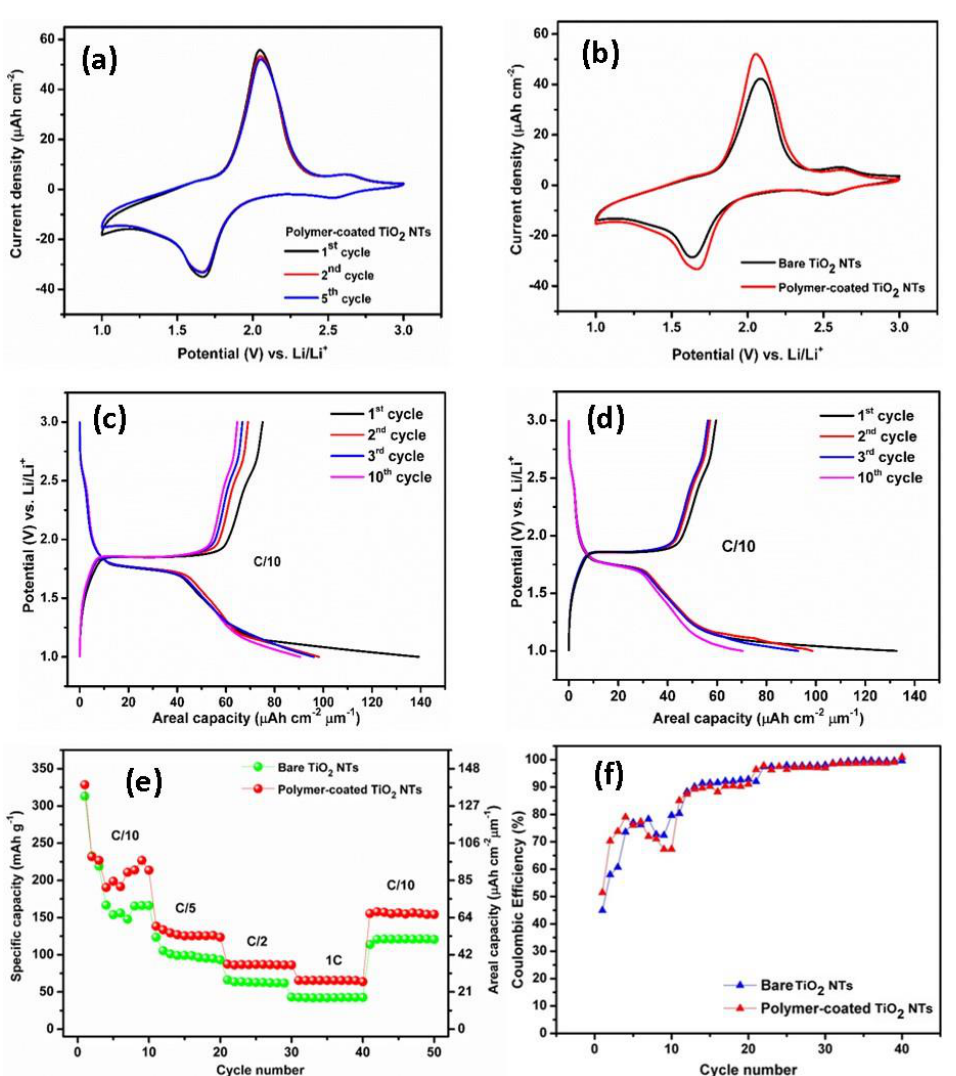
Figure 5. Cyclic voltammogram of the polymer-coated TiO 2 NTs ( a ). Comparison of cyclic voltammograms between bare TiO 2 NTs and polymer-coated TiO 2 NTs ( b ). Typical galvanostatic charge–discharge profiles of the polymer-coated TiO 2 NTs ( c ) and bare TiO 2 NTs ( d ). Rate performance of the bare and polymer-coated TiO 2 NTs ( e ) and Coulombic efficiencies of the bare TiO 2 NTs and polymer-coated TiO 2 NTs at C/10 to 1C rate ( f ).